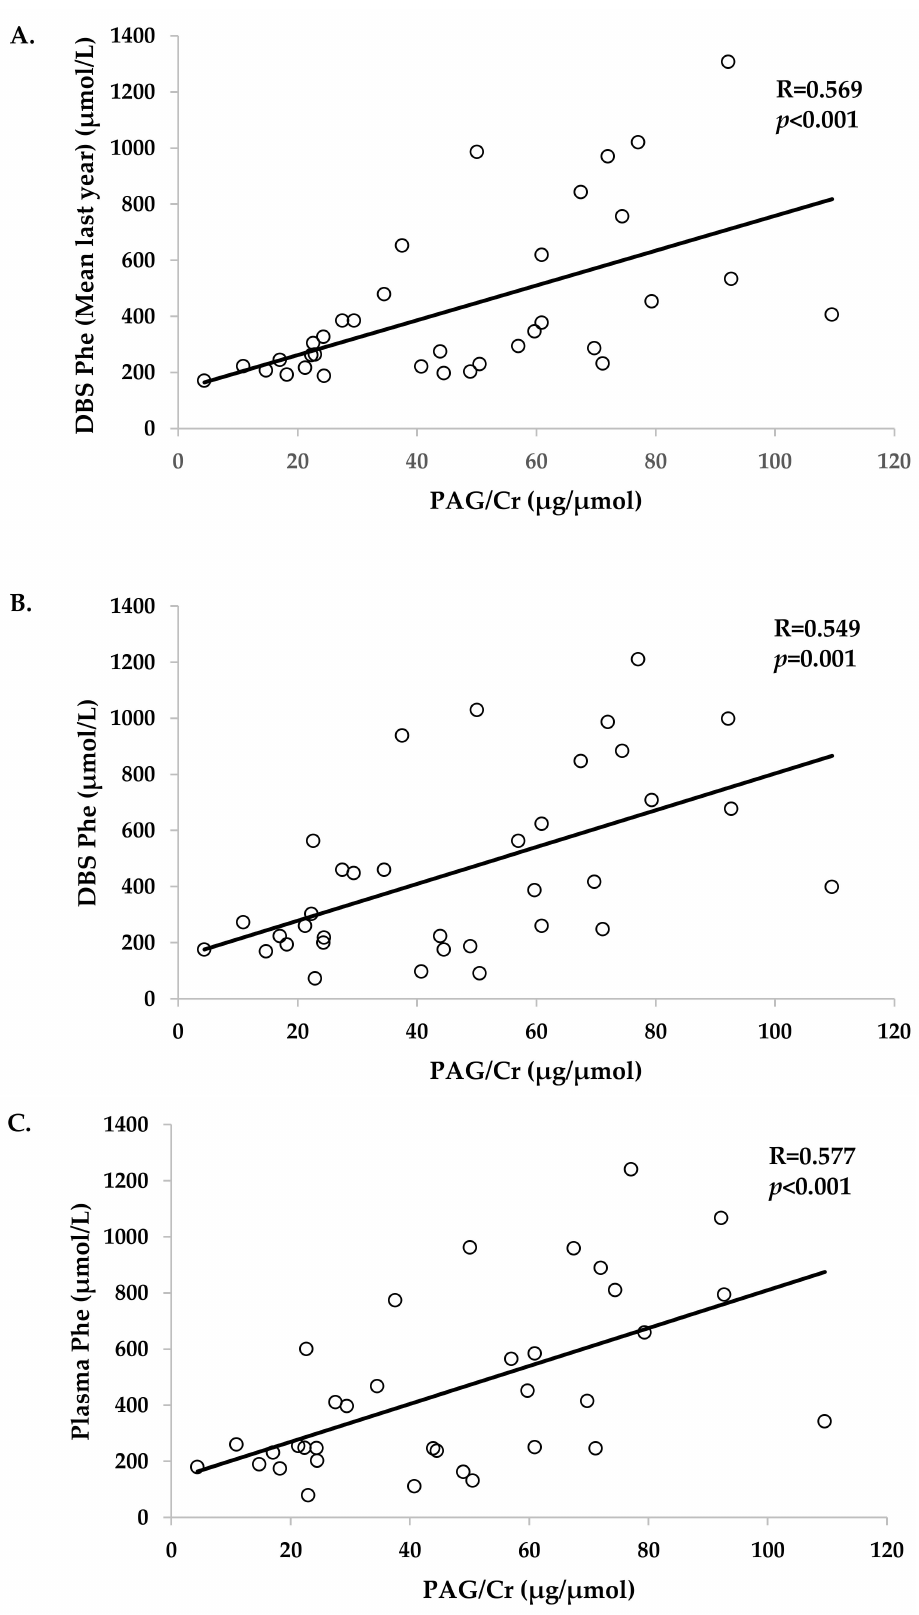
Figure 2. Correlations between urine PAG/Cr and ( A ) mean of the last year DBS Phe levels, ( B ) DBS Phe levels the day of the visit, and ( C ) plasma Phe levels the day of the visit ( C ). Phenylacetylglu- tamine (PAG), creatinine (Cr), dried blood spot (DBS), phenylalanine